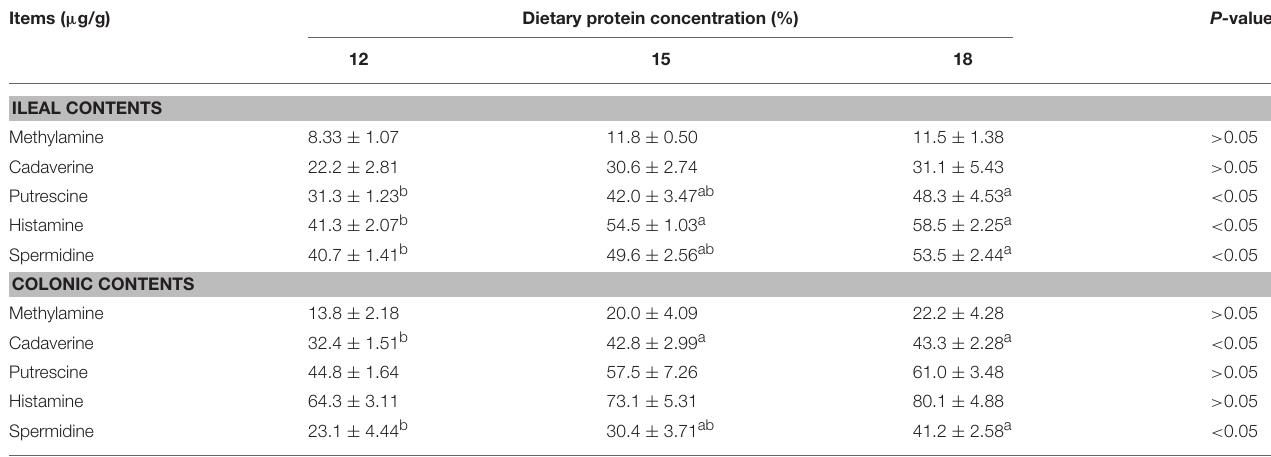
TABLE 2 | Effects of low-protein diets on biogenic amines concentration in intestinal contents of growing pigs. Items ( µ